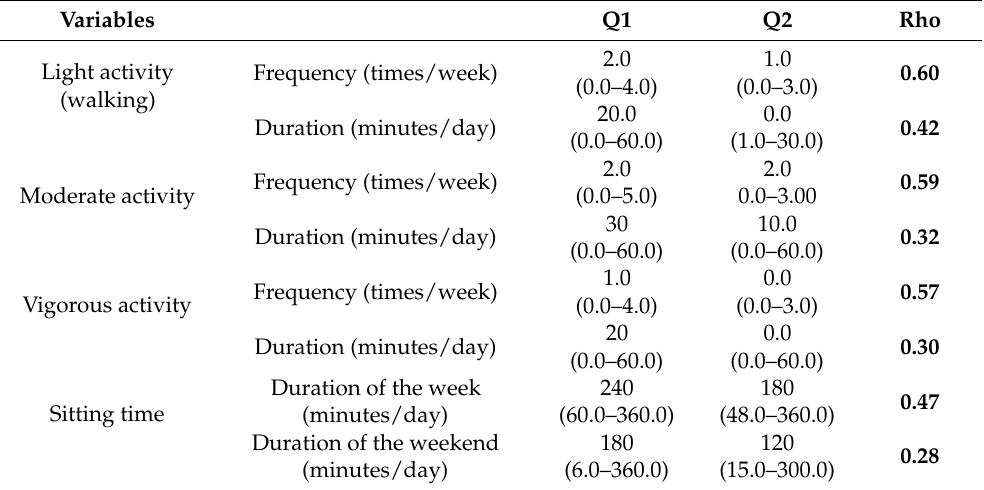
Table 2. Reliability analysis of the International Physical Activity Questionnaire short form (IPAQ-SF).